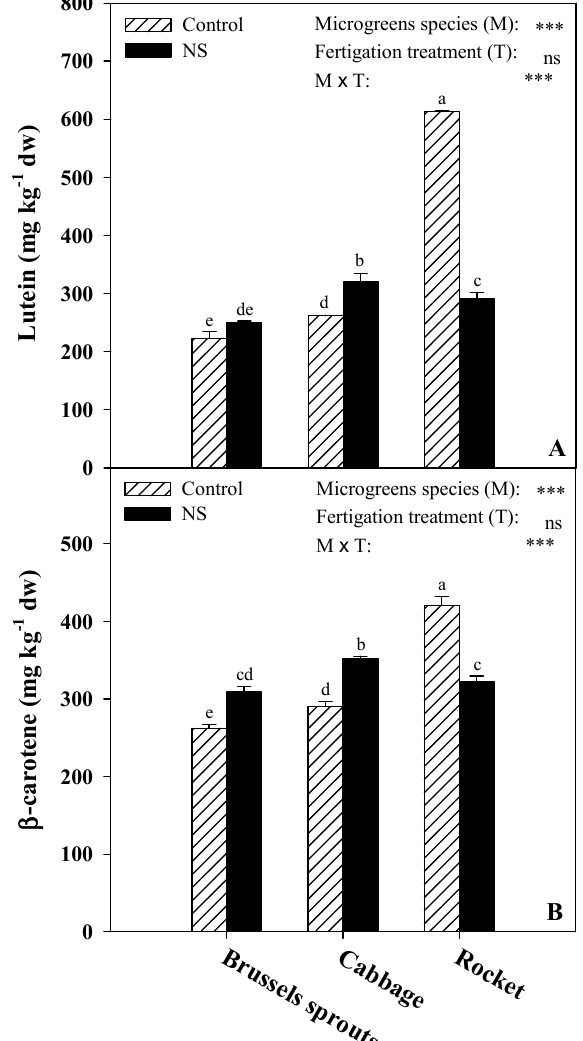
Figure 2. Lutein (A) and β -carotene (B) of microgreens species in light of the nutrient solution treatment. Control: without nutrient supplementation; NS: with nutrient supplementation. All data are expressed as mean ± SE, n = 3. ns, *** denote non-significant or significant effects at p ≤ 0.001. Different letters (a–e; A and a–d; B ) indicate significant differences compared by Duncan’s multiple-range test ( p = 0.05).